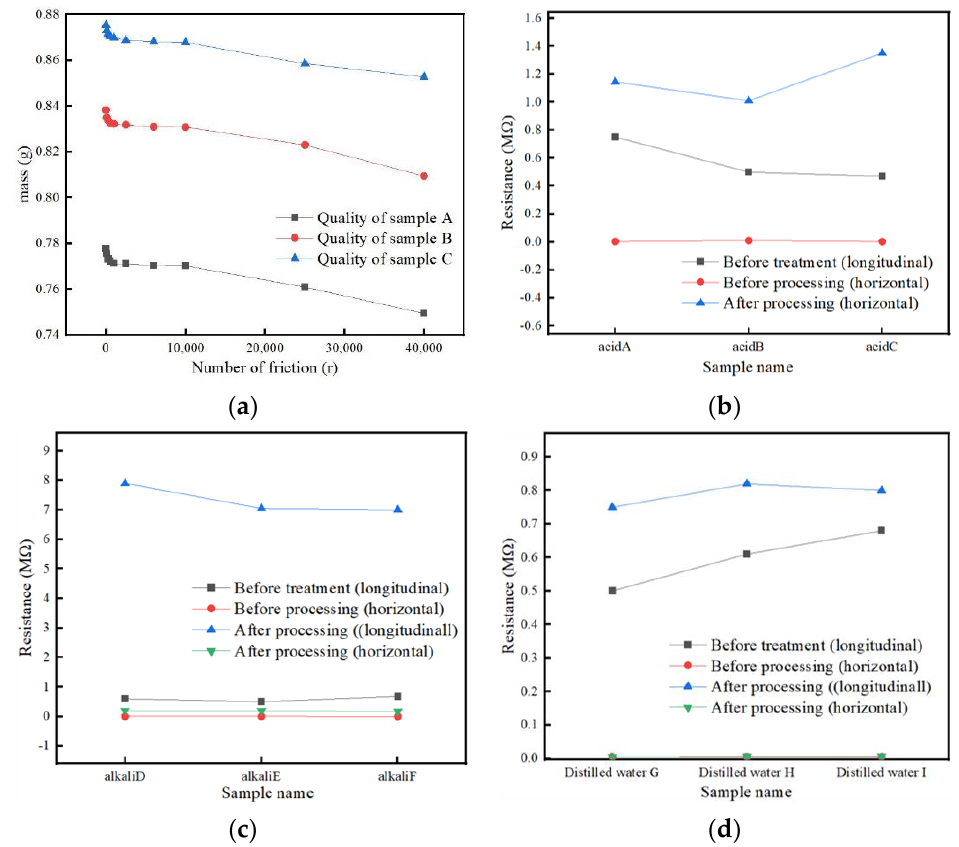
Figure 10. Embroidery fabric electrode mass loss line chart ( a ). Figure ( b ) shows the resistance changes in vertical and horizontal direction of the three embroidery fabric electrode samples after acid sweat treatment. The resistance changes in vertical direction are the largest after acid sweat treatment, which may be due to being out of range or poor contact. Figure ( c ) shows the changes of electrical resistance in the vertical and horizontal directions of the three embroidery fabric electrode samples after alkaline sweat treatment. The electrical resistance in both directions increases significantly, but the changes are less than those of the electrode samples treated with acidic sweat. Figure ( d ) shows the vertical and horizontal resistance changes of three stainless steel yarn embroidery fabric electrode samples treated with distilled water. It can be seen that distilled water has little influence on electrode resistance.